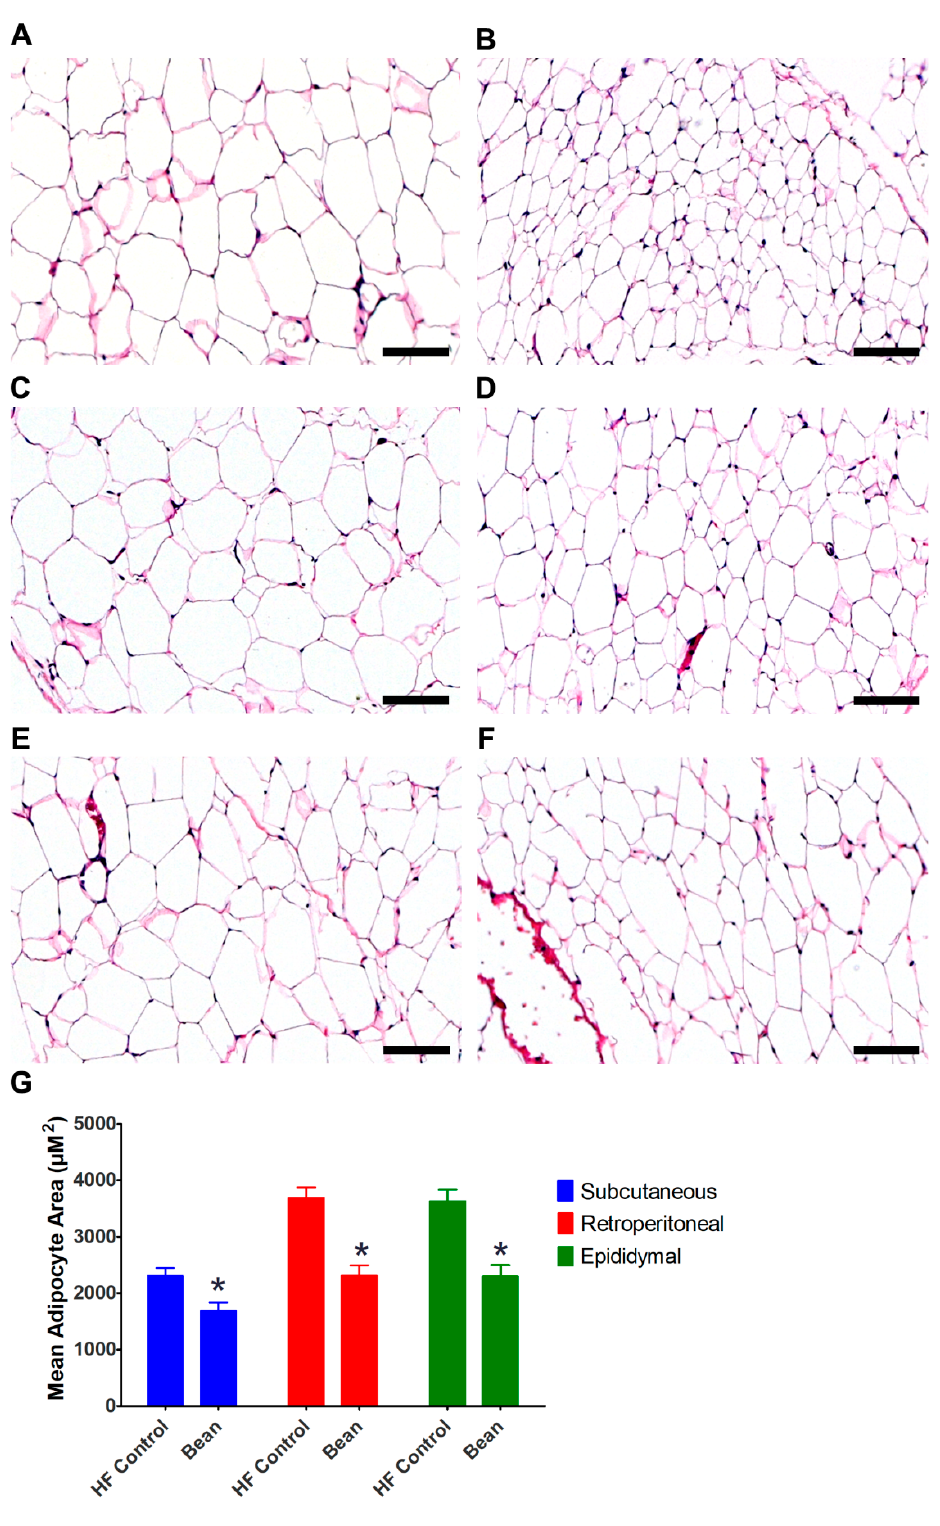
Figure 3. Representative H&E stained sections of fat depots (Experiment 2). ( A ) HF Control subcutaneous fat; ( B ) Bean subcutaneous fat; ( C ) HF Control retroperitoneal fat; ( D ) Bean retroperitoneal fat; ( E ) HF Control epididymal fat; ( F ) Bean epididymal fat; ( G ) Adipocyte morphometry; ANOVA: subcutaneous adipocyte area p = 0.0094, retroperitoneal adipocyte area p = 0.0001, epididymal adipocyte area p = 0.0004; * different relative to control diet ( p ≤ 0.05); all images 100 × magnification, bars = 100 µM; HF Control n = 8, Bean n = 8; HF: high fat.